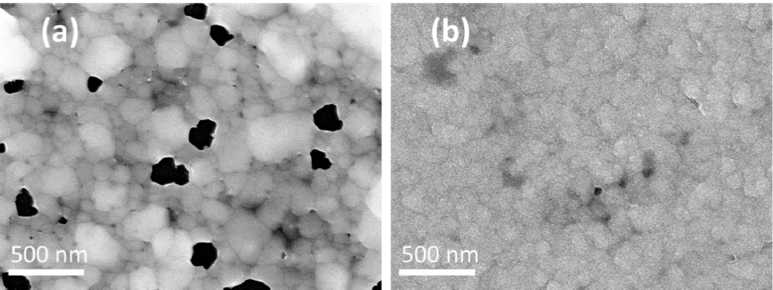
Figure 4. FE–SEM images show the sintering of micro-heater with different numbers of printed silver layers: ( a ) single-layer printing and ( b ) four-layer printing.